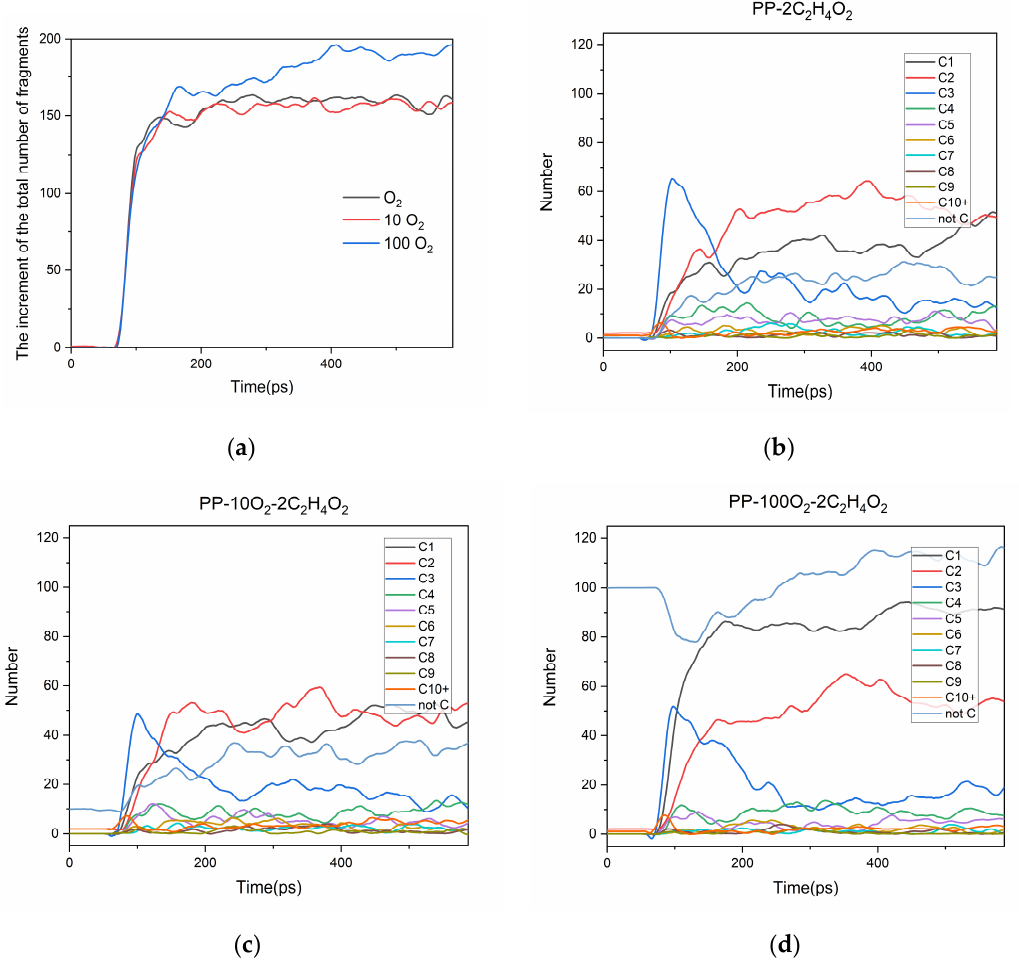
Figure 5. ( a ) The increment of the total number of fragments at different oxygen levels. The distribution of major products at ( b ) no O 2 ; ( c ) 10 O 2 ; ( d ) 100 O